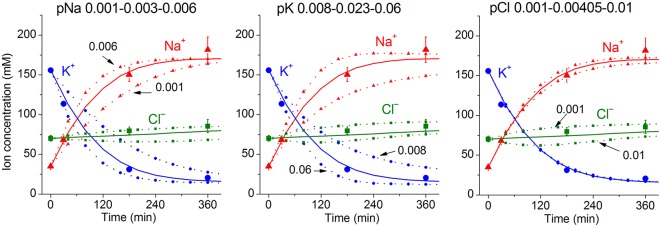
Dependence of calculated K+, Na+, Cl− redistribution dynamics after blocking the pump on K+, Na+, and Cl− channel permeabilities. Experimental data are shown by the large symbols. Solid lines—data calculated for the following parameters: na0 140, k0 5.8, cl0 116, B0 48.2, kv 1, na 35, k 156, cl 70, beta 0.001, pna 0.00301, pk 0.023, pcl 0.00405, inc 3.4E-5, ikc = inkcc = 0, (before blocking the pump beta was 0.039), gamma 1.5. Dotted lines with small symbols—data calculated for parameter values indicated above the graphs.